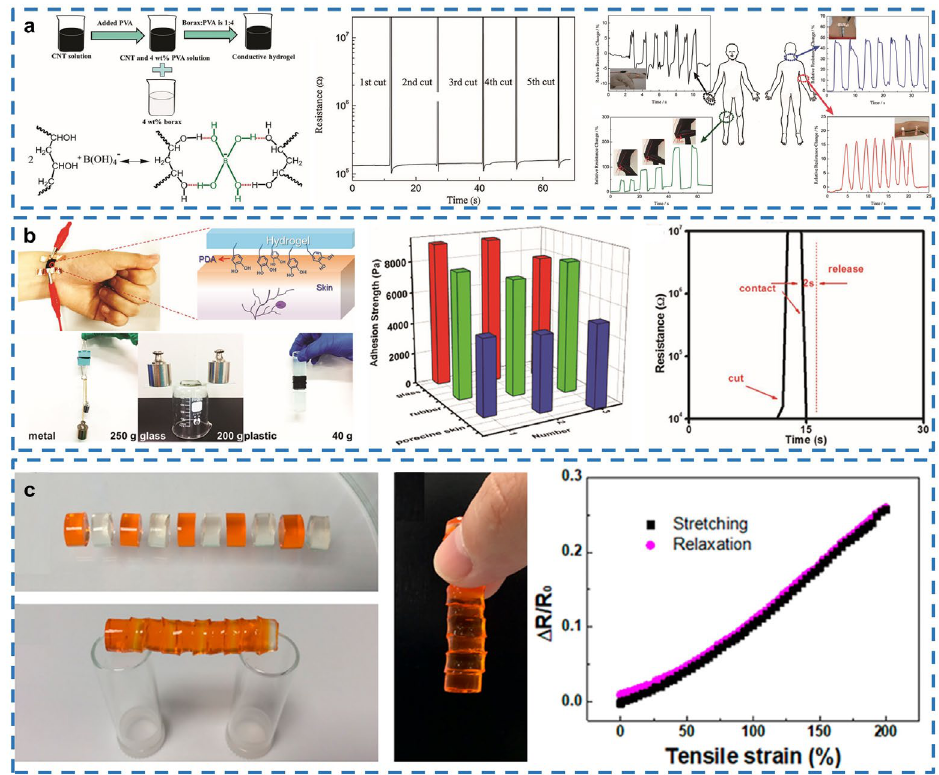
Figure 1. Self-healing motion sensors. ( a ) Conductive SWCNT–hydrogel based self-healing